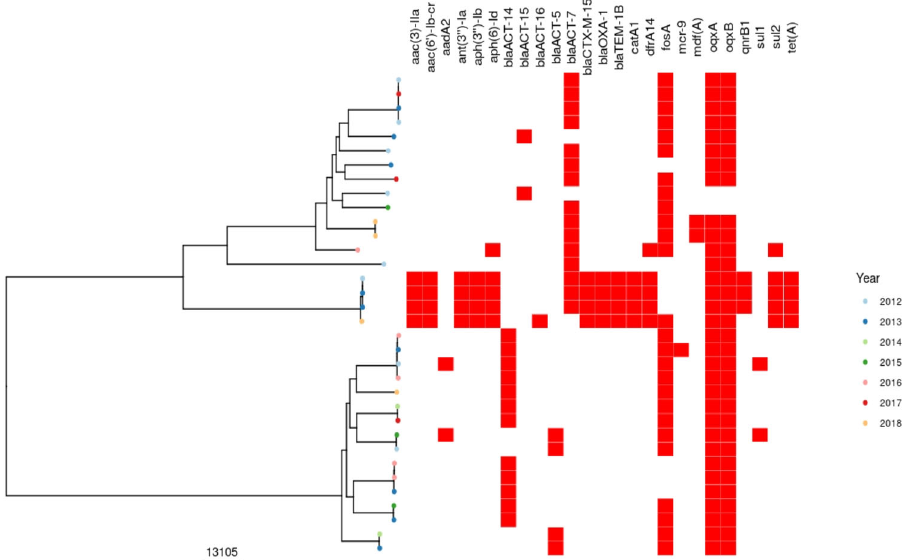
Fig. 4 Recombination-corrected phylogeny of Enterobacter hormaechei isolates sequenced in this study. Tree tip colours show the year of isolates, red bars denote the presence/absence of antimicrobial-resistance genes. The scale of the tree is shown in